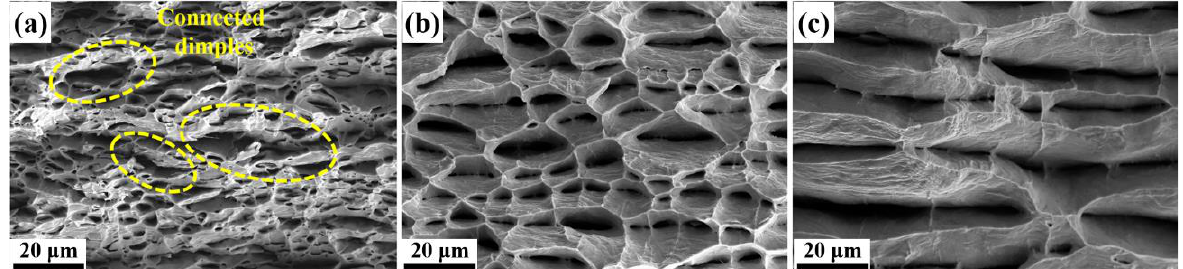
Figure 8. Fracture morphologies of GNS/Cu composites with initial Cu foil thickness of ( a ) 10 μm, ( b ) 30 μm , and ( c ) 50 μm.